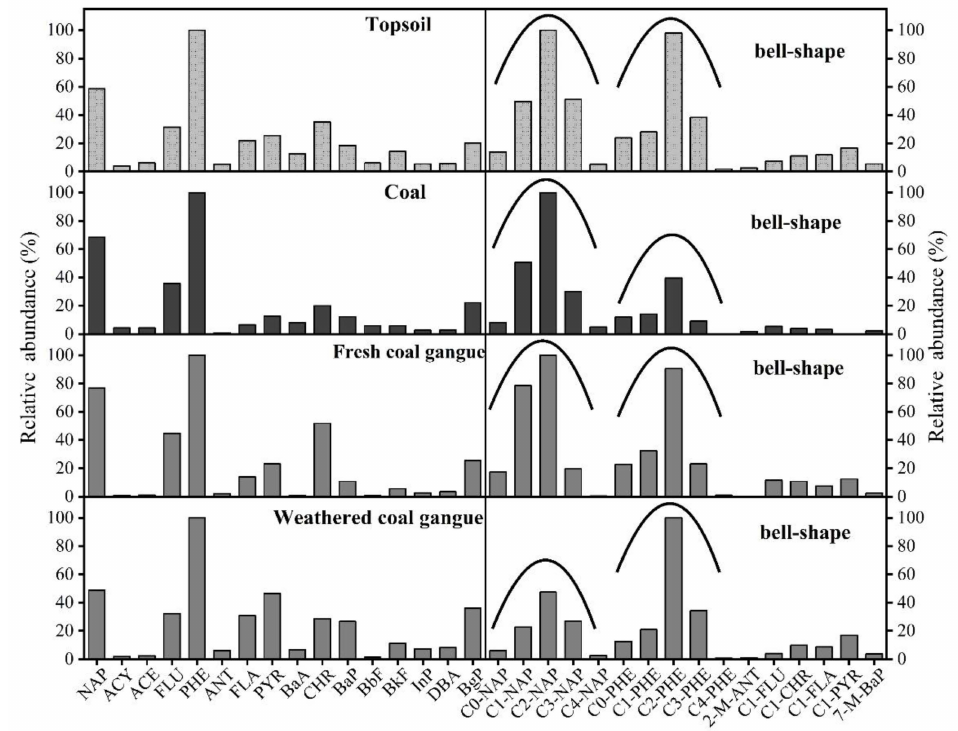
Figure 6. PAC fingerprint information and bell-shaped distribution pattern from different types of samples. The bell-shaped distribution means that the content of APAHs is higher than that of parent PAHs, and the relative abundance of C0–C4 PAHs is high in the middle and low on both